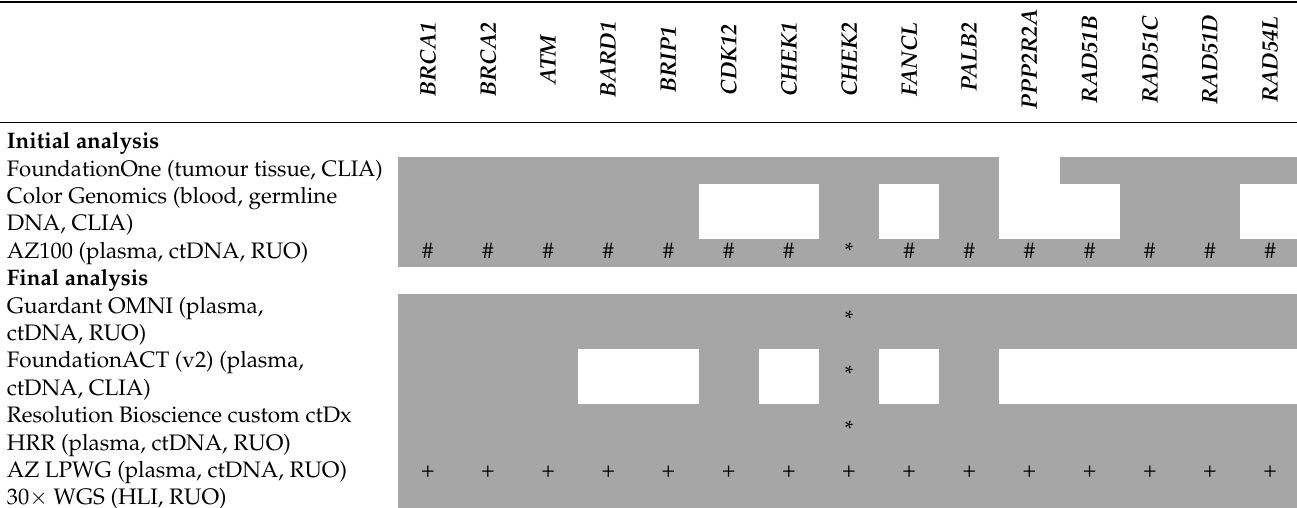
Table 1. Coverage of 15 HRR genes by the assays used in this